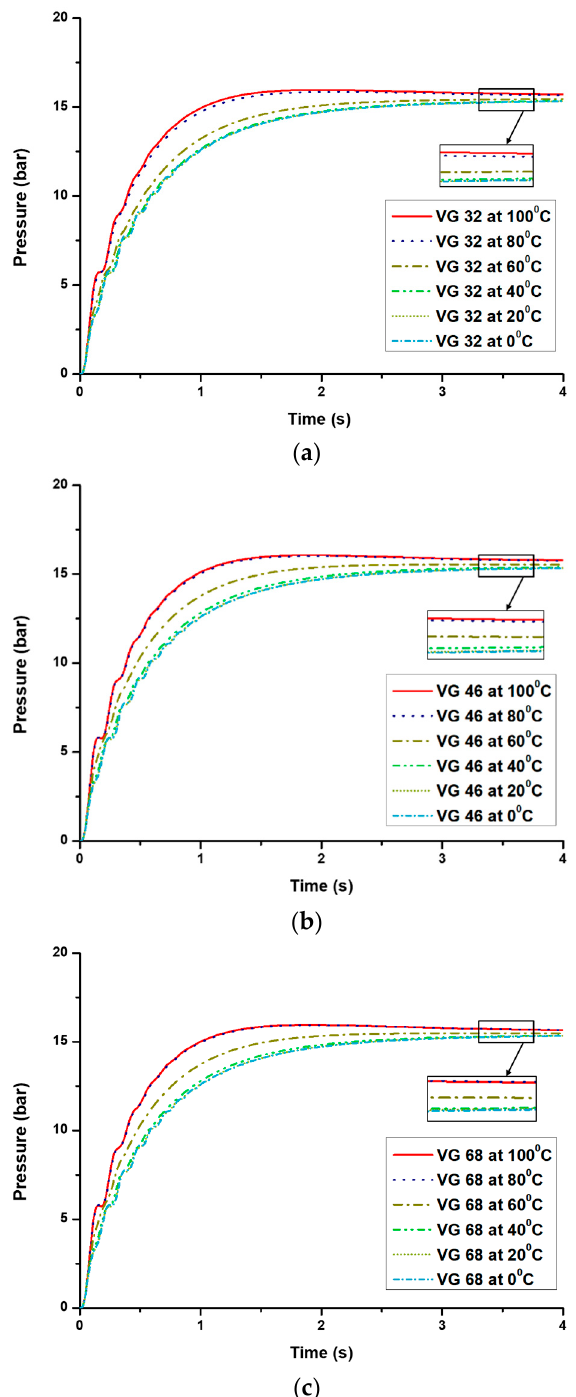
Figure 9. Performance of the control algorithm without considering viscosity at various temperatures, namely: ( a ) hydraulic oils VG 32, ( b ) VG 46, and ( c ) VG